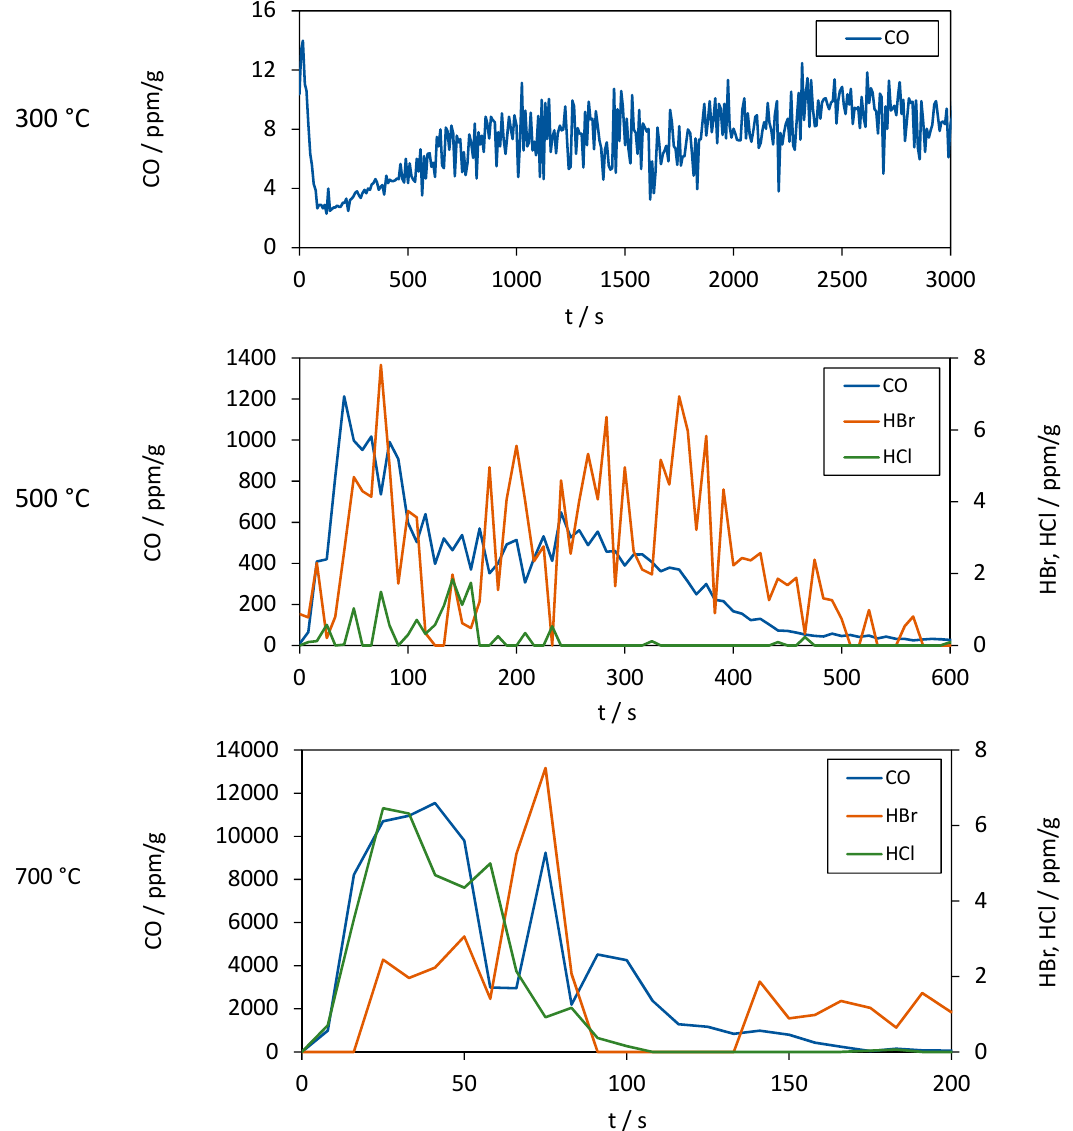
Figure 5. Concentrations of CO, HBr and HCl during the pyrolysis of display powder at 300, 500 and 700 °C.